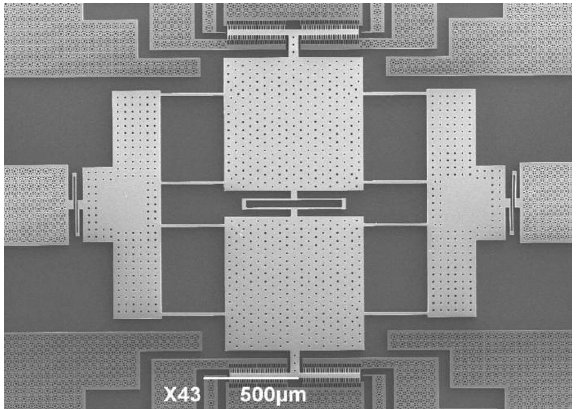
Figure 8. SEM picture showing the completely released resonator